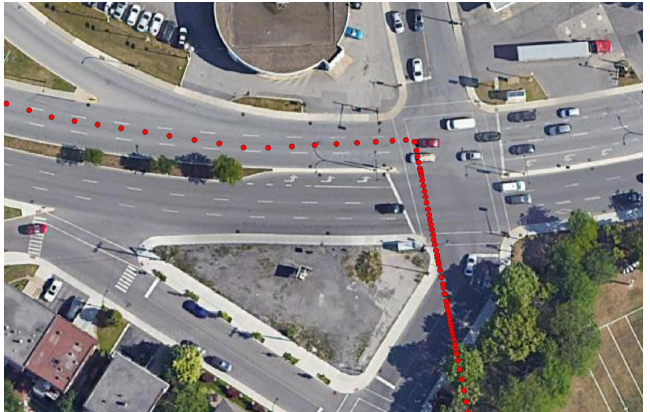
Figure 4. GPS points on a route with different distances between